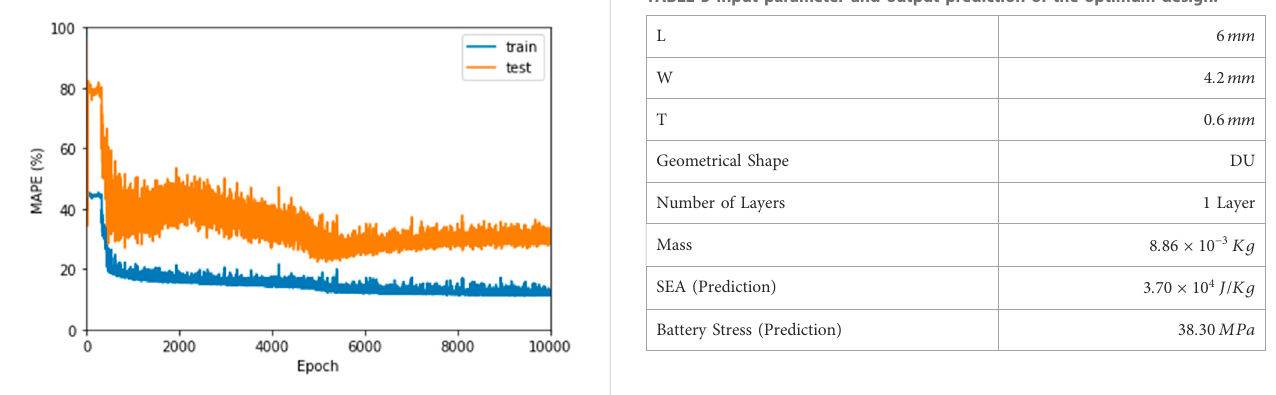
FIGURE 15 MAPE in ANN training of Stress predictor vs. Epoch.